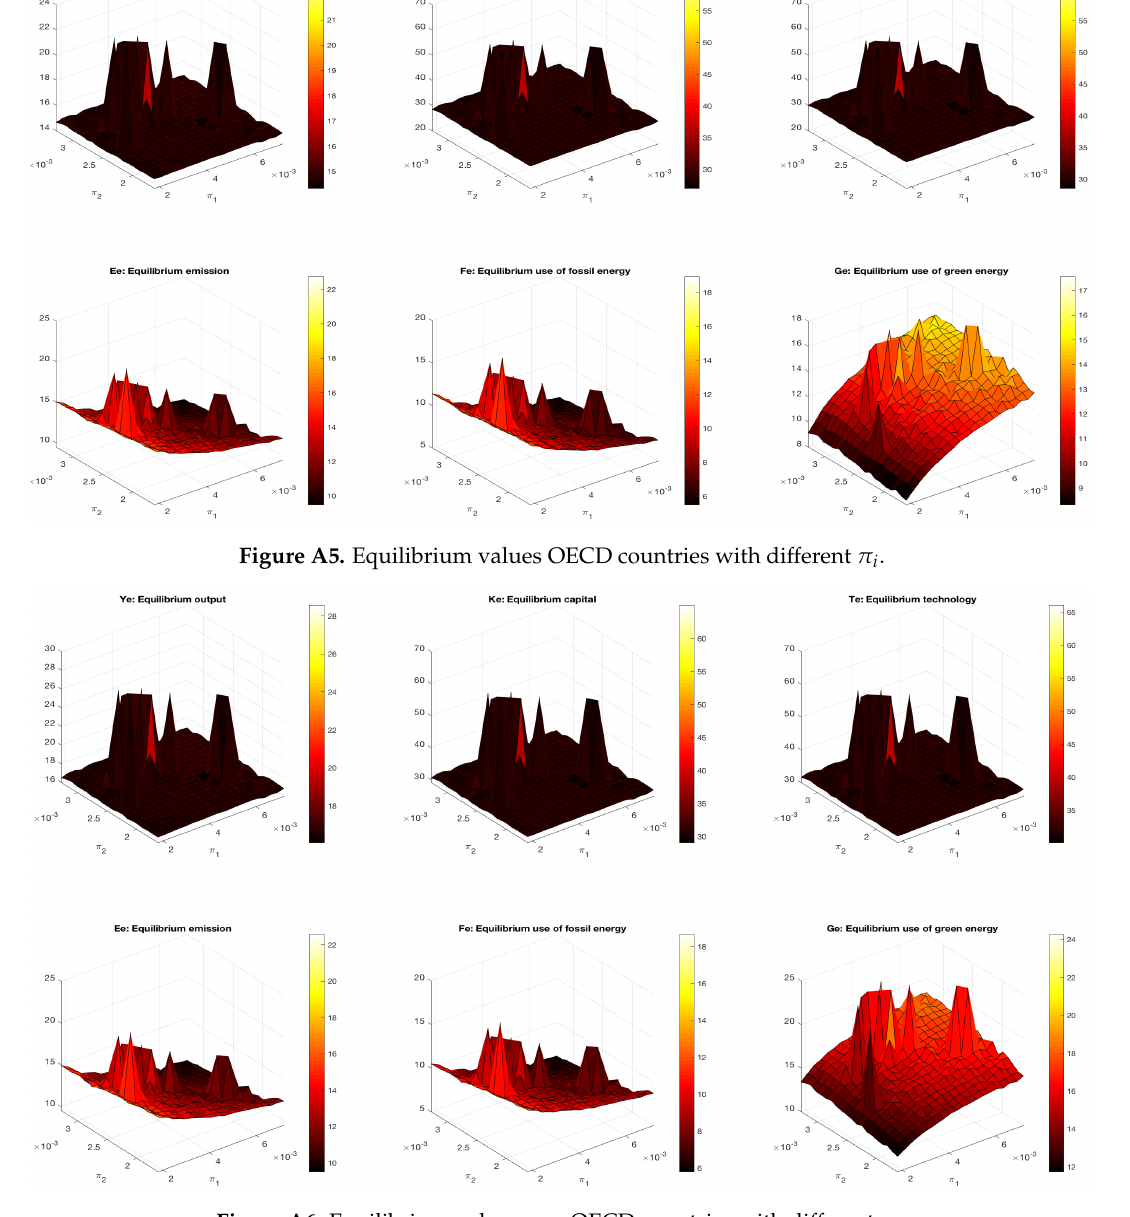
Figure A6. Equilibrium values non-OECD countries with different π i .